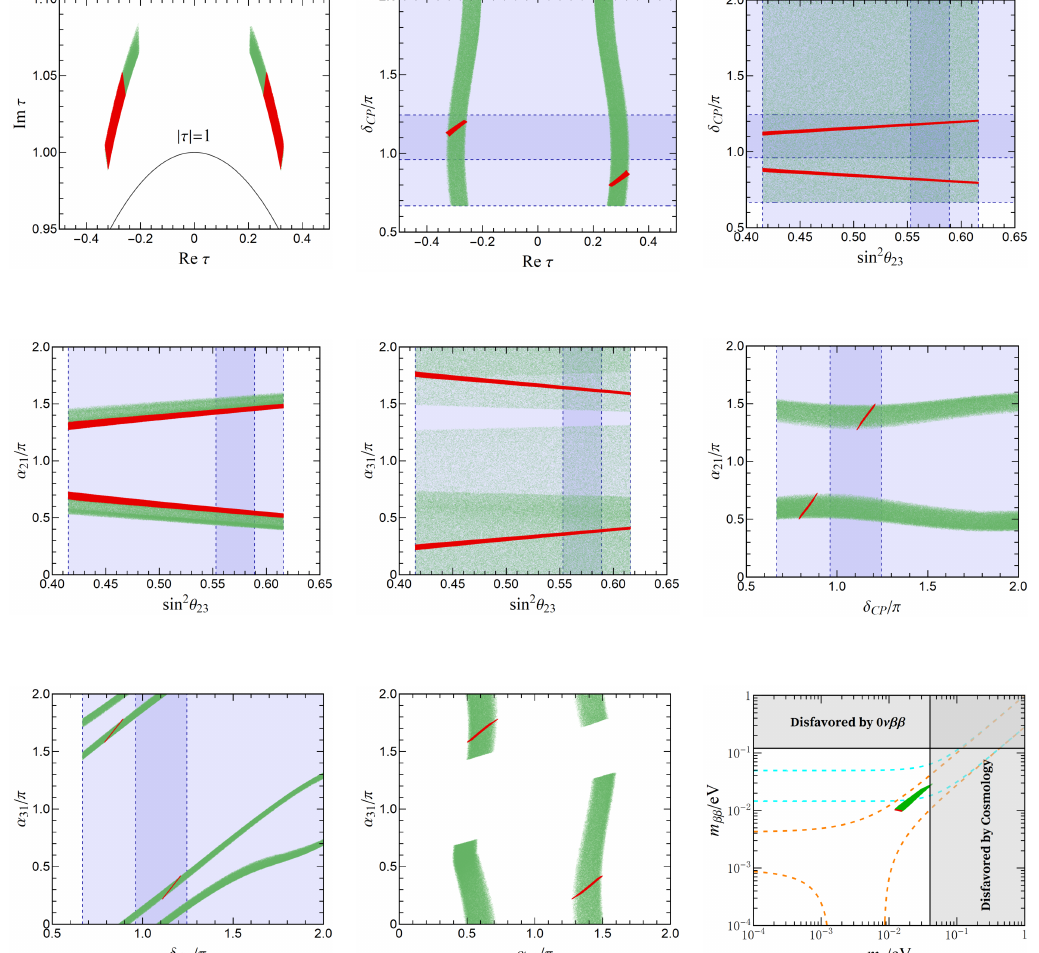
Figure 1 . The experimentally allowed values of the complex modulus τ and the correlations between the neutrino mixing parameters in the example model of type II. The green and red regions denote points compatible with experimental data for models without and with gCP respectively. The light blue bounds represent the 1 σ and 3 σ ranges respectively [1]. The orange (cyan) dashed lines in the last panel represent the most general allowed regions for NO (IO) neutrino masses respectively, where the neutrino oscillation parameter are varied within their 3 σ ranges. The present upper limit m ββ < (61 – 165) meV from KamLAND-Zen [81] is shown by horizontal grey band. The vertical grey exclusion band denotes the current bound from the cosmological data of P 0 . 120 eV at 95% confidence level given by the Planck collaboration